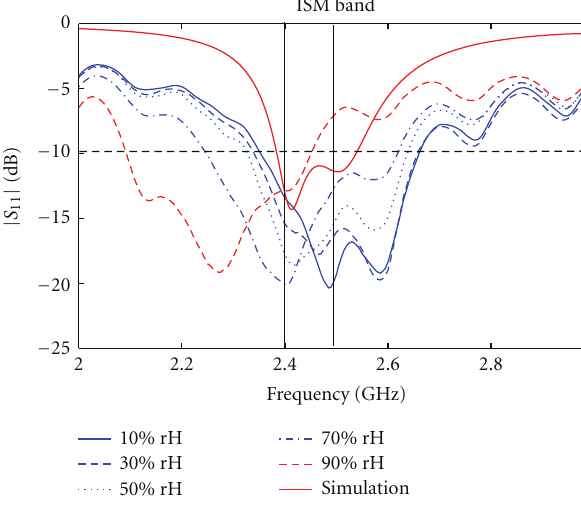
Figure 10: Array on Azzurri: reflection coe ffi cients, simulation (full line) versus measurements (dashed line).